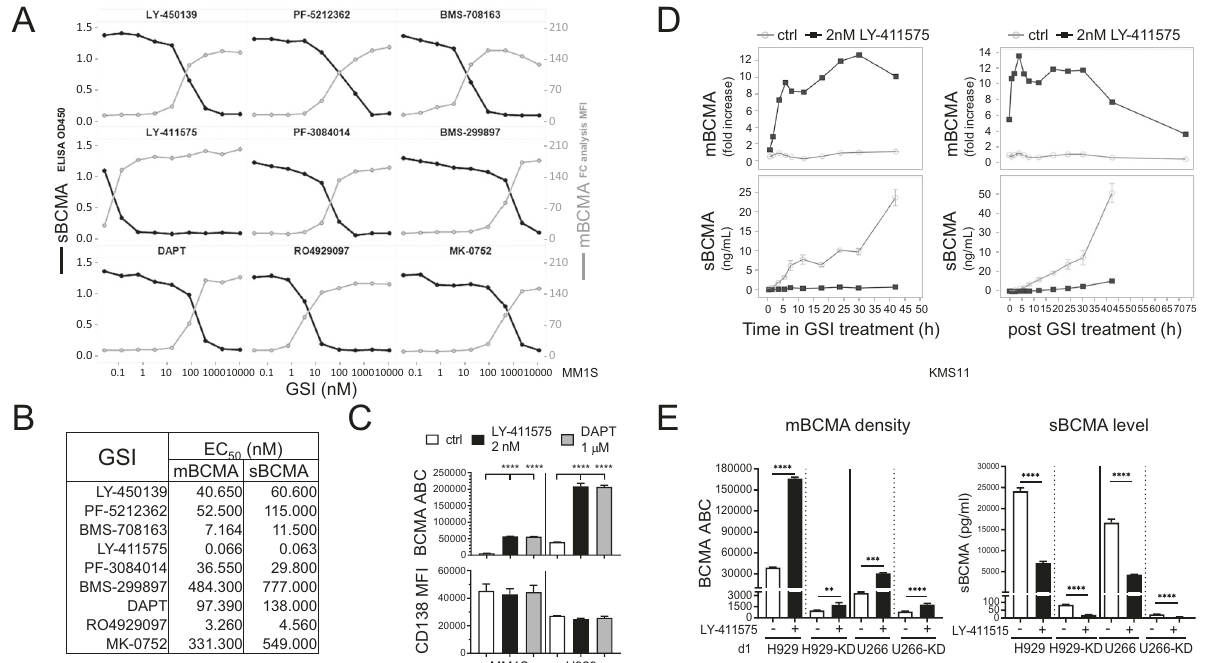
Fig. 1 GSIs signi fi cantly enhanced mBCMA densities on MM cell lines and depleted sBCMA in paired cell culture supernatants. MM cell lines ( A – C : MM1S; D : KMS11; C , E : H929; E : U266) were treated with various concentrations of the indicated GSI ( A , B , 9 different GSIs (0.01 – 10,000 nM); C – E 2 nM LY-411575; C 1 μ M DAPT) for 1 day ( A – C , E ) or indicated time periods ( D ) followed by fl ow cytometry (FC) analysis to determine geometric mean fl uorescence intensity (MFI) of BCMA (mBCMA) ( A , gray line, right Y axis; D , upper panels) and CD138 ( C , lower panel). Fold-changes in MFI (to time 0) are shown in D (upper panels). Shed sBCMA concentrations in the paired cell culture supernatants were determined by BCMA-speci fi c ELISA ( A , black lines, left Y axis; D , lower panels; E , right). B EC 50 (nM) values of these GSIs indicated that LY- 411575, most potently, increased mBCMA and diminished sBCMA. Cell membrane BCMA molecules were further quanti fi ed by FC analysis and shown as BCMA antibody binding capacity (ABC) in C (upper panel) and E (left). D Shown are mBCMA MFI fold increases (upper panels) and measurements of sBCMA (lower panels) at indicated LY-411575 (black) treatment time periods (left panels) and indicated time periods (up to 75 h) after removal of LY-411575 (right). LY-411575 was pretreated for 1 day prior to washing (right). Data of vehicle control media (ctrl, gray) was also shown. E Paired control vector-transfected and BCMA-knockdown (KD) H929 and U266 MM cells were used. Three independent experiments were done with each treatment condition in triplicate. Data are presented as means ± standard deviations (SDs) (error bars). ** P < 0.01; *** P < 0.001; **** P <